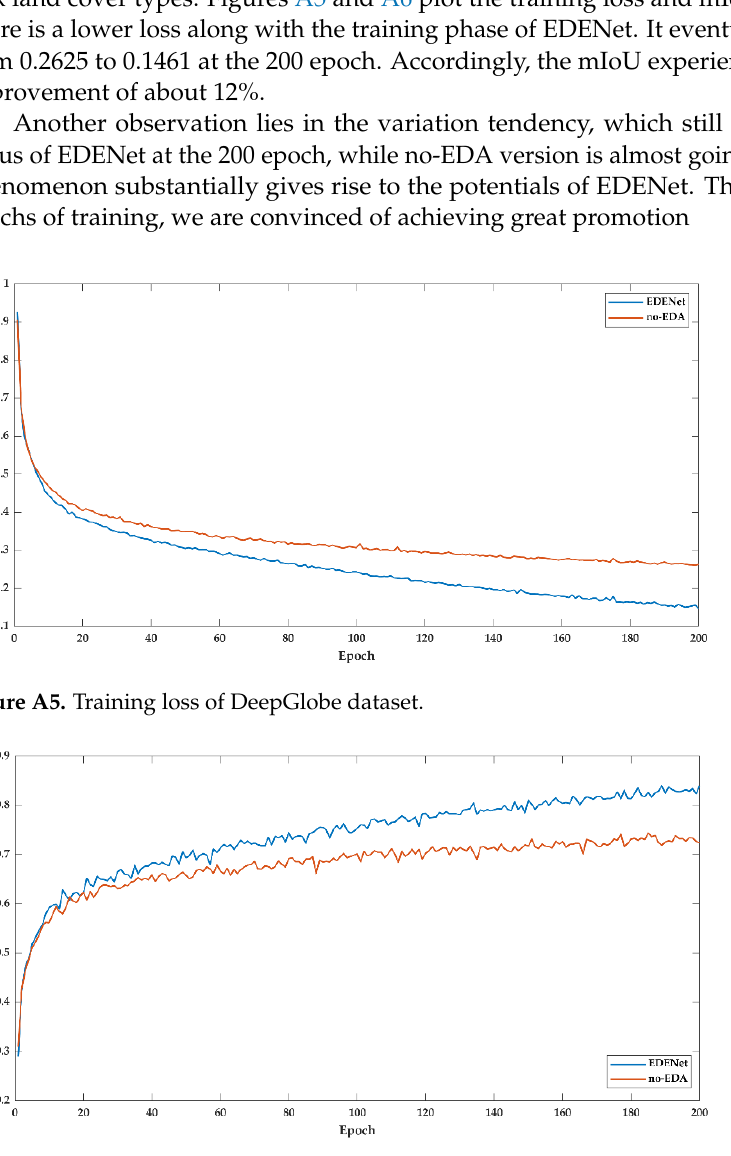
Figure A6. Training mIoU of DeepGlobe dataset.